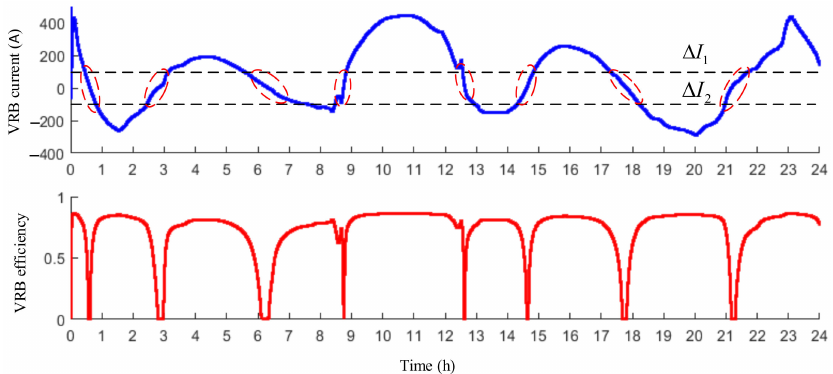
Figure 14. Current flow and operational efficiency of VRB over 24 h based on conventional con- trol